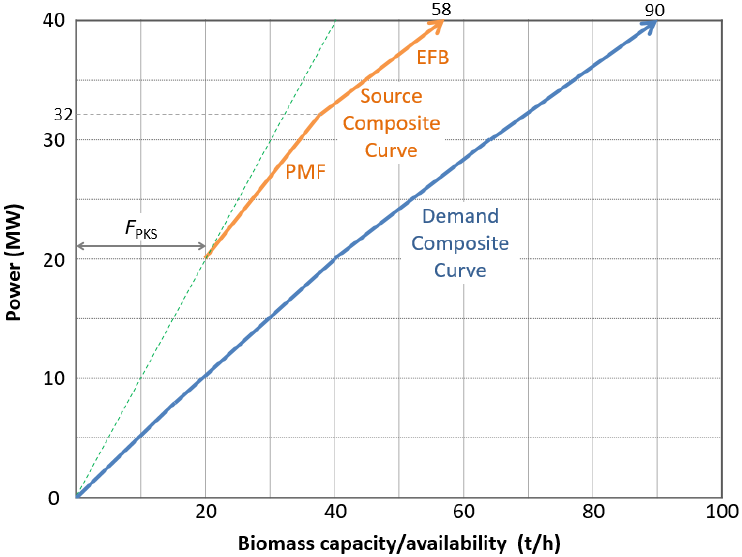
Figure 9. BEPD when three biomass types are used (Scenario 3).